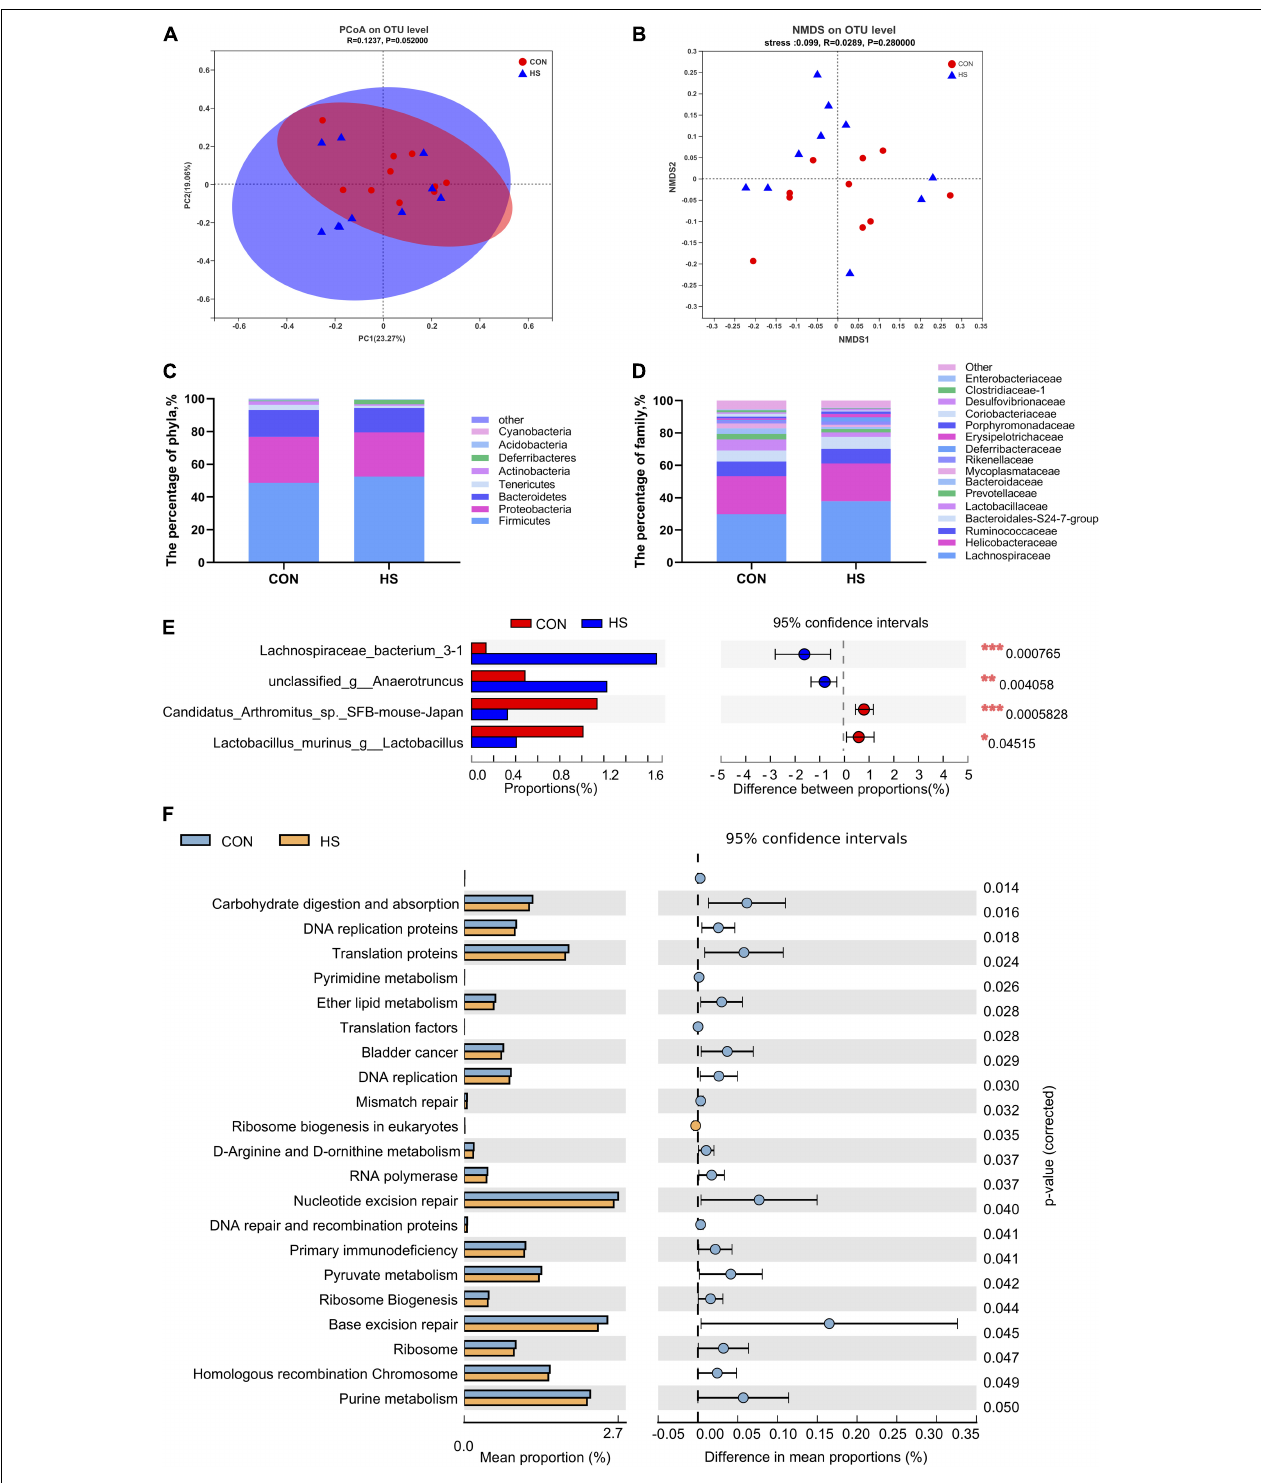
FIGURE 3 | Effects of heat stress on mouse gut microbiota. (A) Analysis of the PCoA plots based on a Bray-Curtis distance metric. (B) NMDS ordination plots of cecal bacterial communications in the HS and CON group based on the Bray-Curtis distance metric. (C) Differential microorganisms at the phylum level. (D) Differential microorganisms at the family level. (E) T -test bar plot of significantly different species between the groups (relative abundance > 1%). (F) T -test bar plot of significantly differed pathways enriched at KEGG level 3. CON, control group; HS, heat stress group; PCoA, principal coordinates analysis; NMDS, Non-metric multidimensional